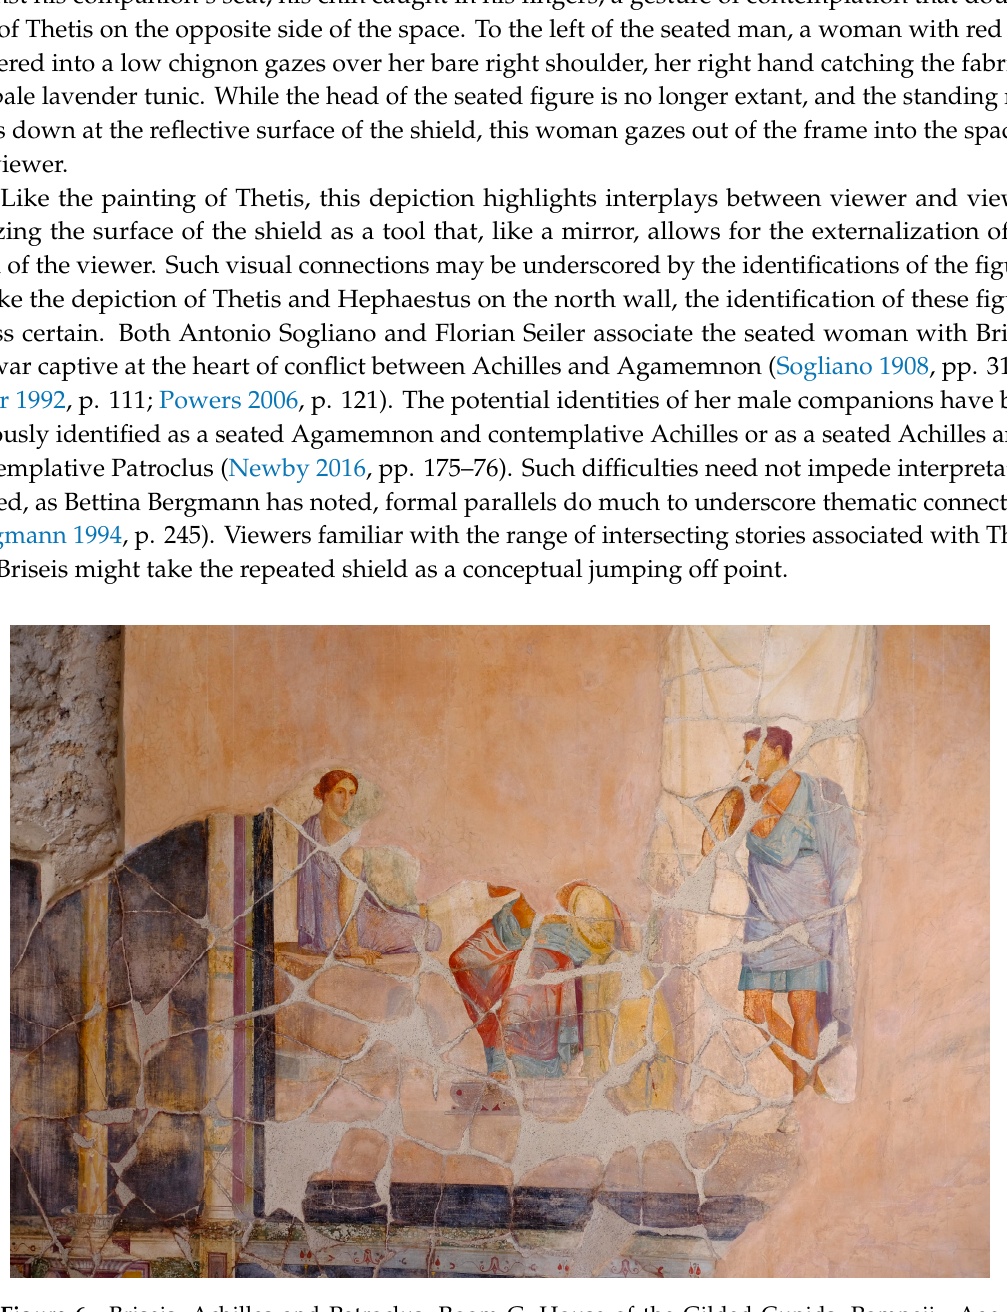
Figure 6. Briseis, Achilles and Patroclus, Room G, House of the Gilded Cupids, Pompeii. Age Fotostock/Alamy Stock Photo. Used by permission.